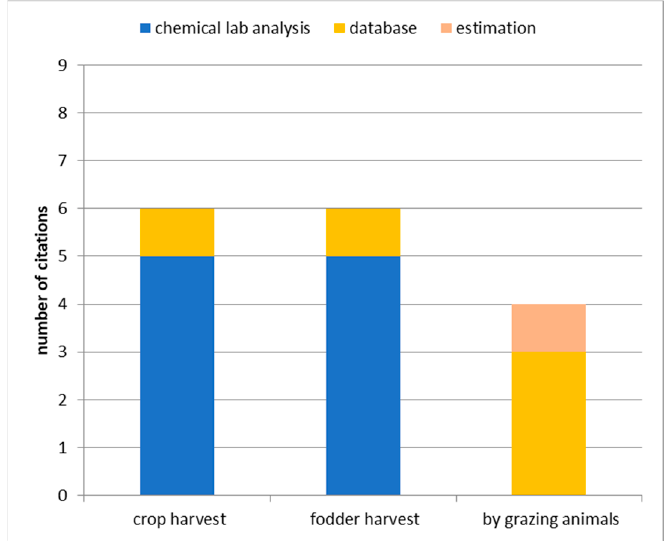
Figure 6. Qualitative determination of elements of nitrogen removal of soil surface budgets; multiple answers are possible (Source: expert survey results).